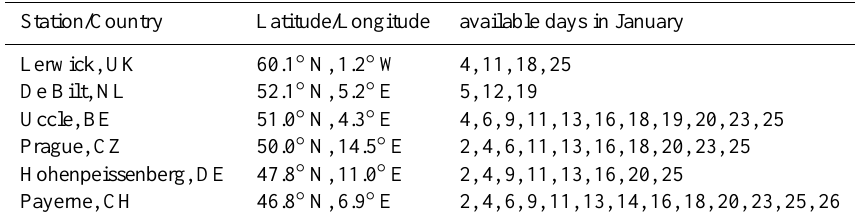
Table 1. Overview of the ozone sounding stations from which data were